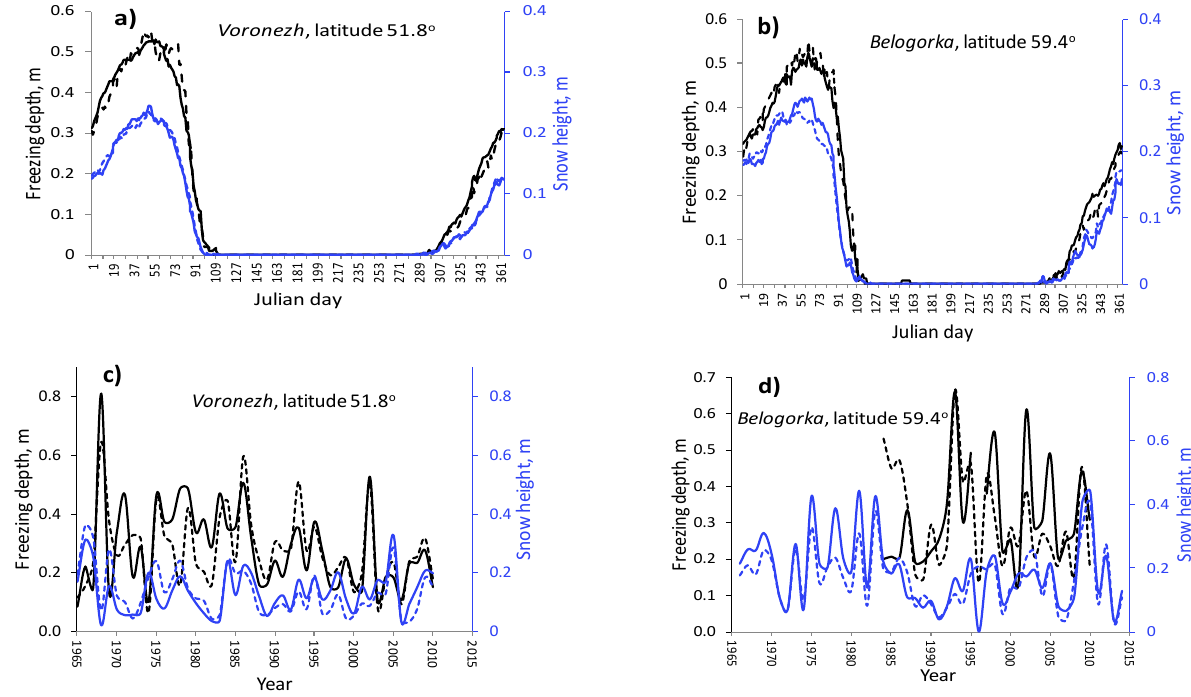
Figure 2. Observed (lines) and simulated (dashed lines) average intra-annual ( a,b ) and average winter ( c,d ) values of freezing depth (black lines) and snow height (blue lines) for Voronezh ( a,c ) and Belogorka ( b,d ) weather stations.